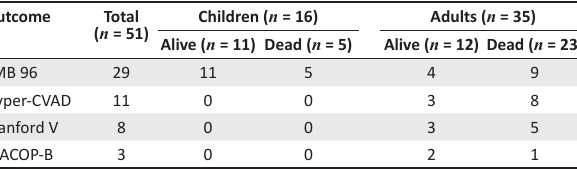
MACOP-B, methotrexate, bleomycin, adriamycin, cyclophosphamide, vincristine, dexamethasone; hyper CVAD, hyperfractionated cyclophosphamide, vincristine, cytarabine, doxorubicin.